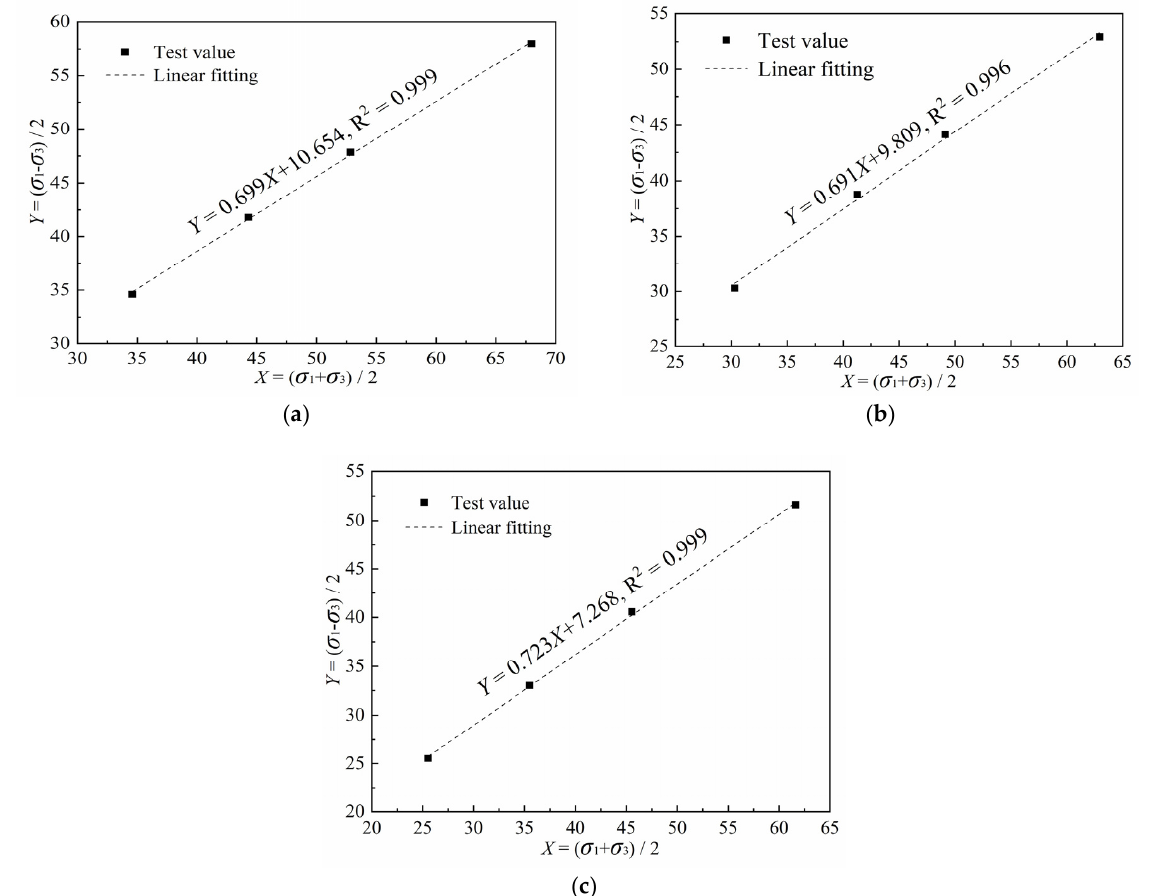
Figure 9. Calculation process of c and φ of RAC under different curing conditions. (a) RAC20, (b) RAC6012, (c) RAC8009 Table 4. Fitting parameters determined by the Mohr–Coulomb criterion. Fitting Parameters